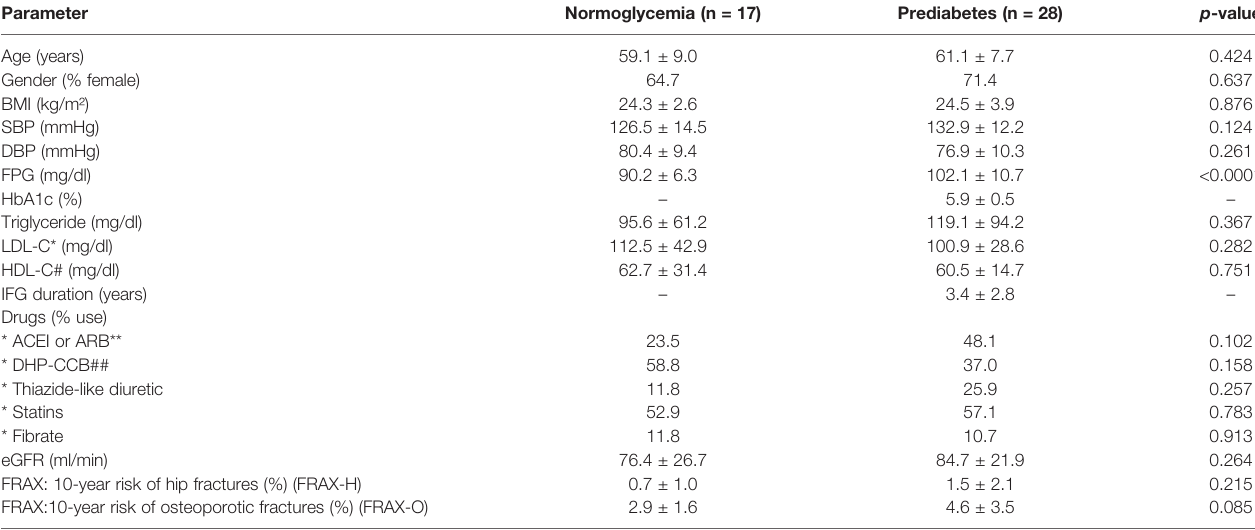
TABLE 2 | Clinical Characteristics of the Study Participants.